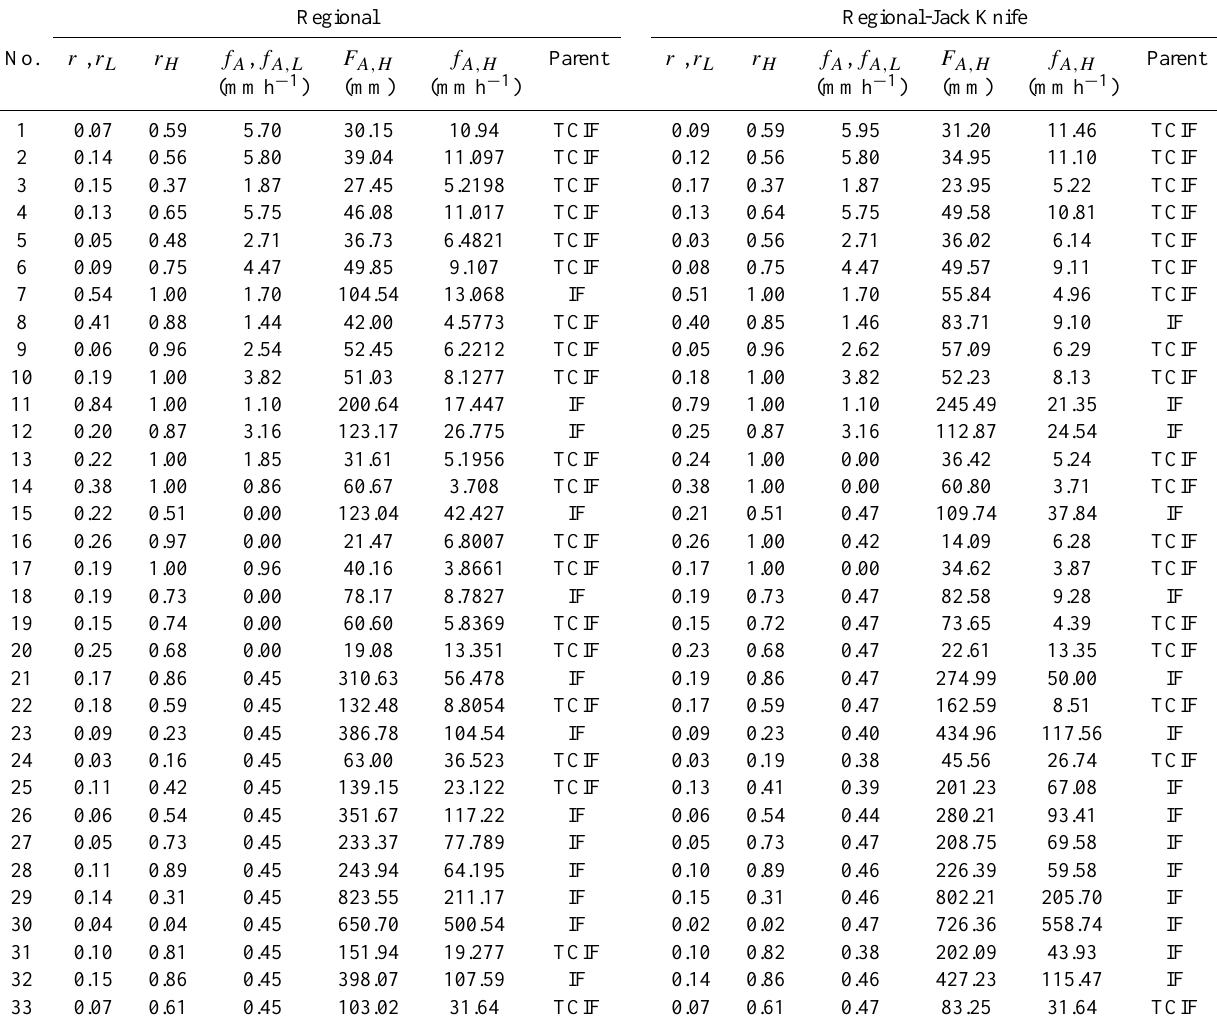
Table 5. Regional estimates of parameters r,r L ,r H ,f a ,f a,L ,f a,H